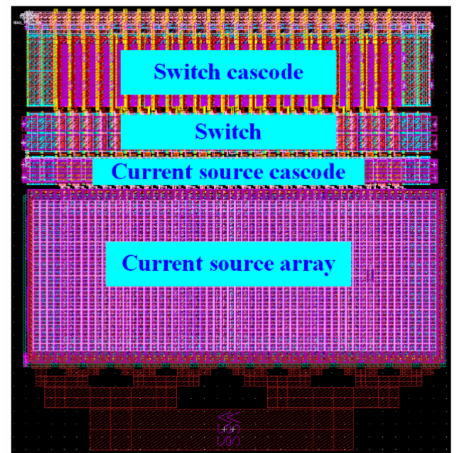
Figure 6. The switching current array layout.